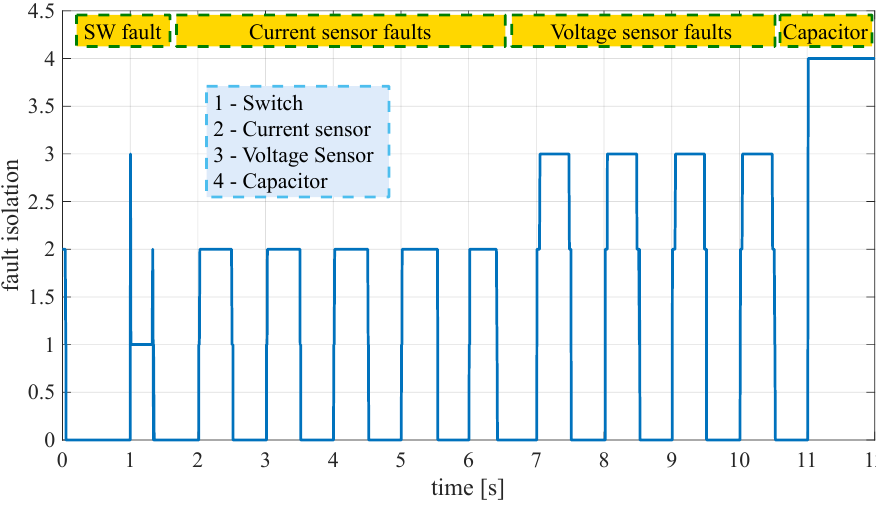
Figure 11. Boost simulation: flags for FDI with R o = 35 Ω